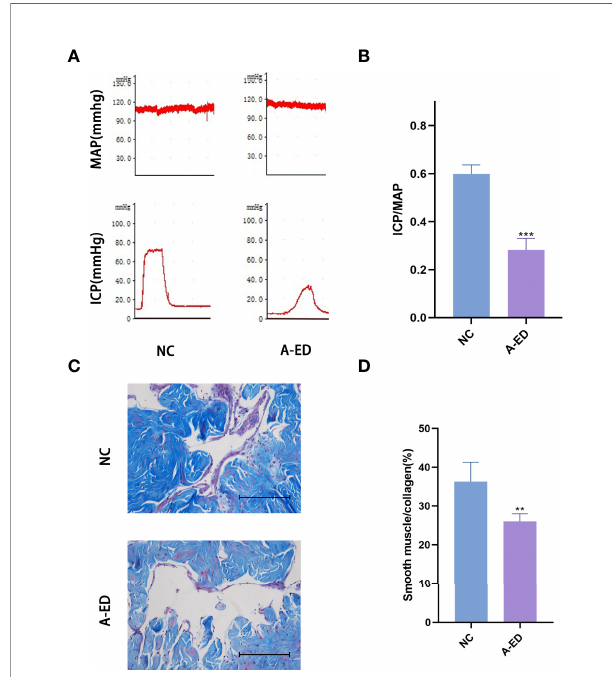
FIGURE 1 | Evaluation of Erectile Dysfunction (A) : Mean arterial pressure (MAP) and intracavernous pressure (ICP) of rats in the A-ED group and NC group. (B) : Bar plot of the ICP/MAP of A-ED group and NC group. ***p < 0.001. (C) : Masson-trichrome (Masson) staining showing the fi brosis in the A- ED and NC groups. (D) Bar plot of the ratio of smooth muscle to collagen in the A-ED and NC groups. **p <